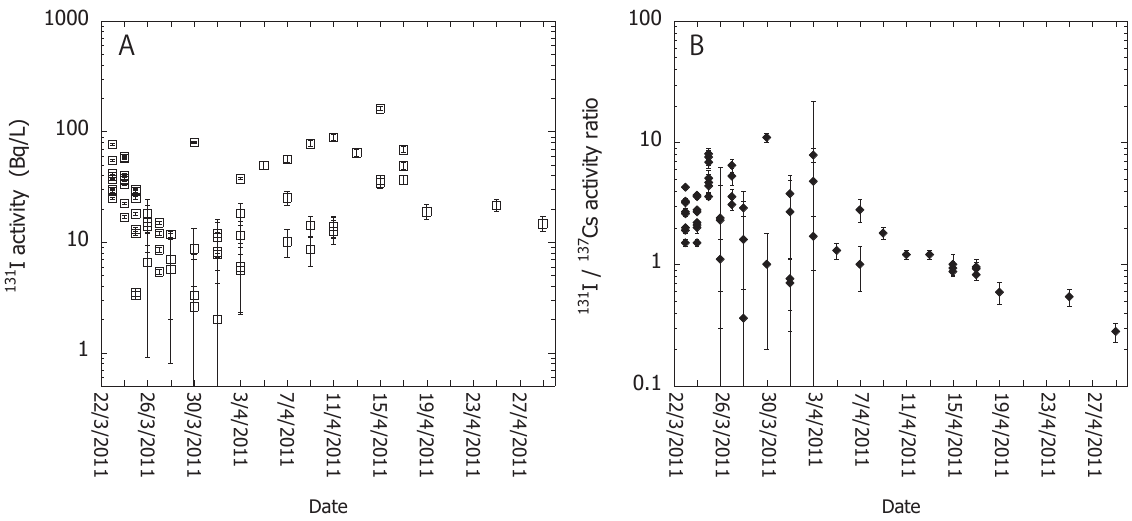
Fig. 2. Temporal variation of 131 I activities in surface waters (A) and 131 I/ 137 Cs activity ratios in surface waters (B) .